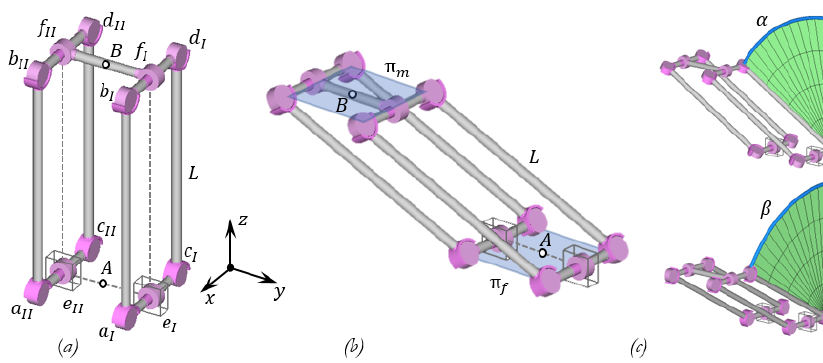
Figure 3. Pa 2 joint. Modelization and associated motion.